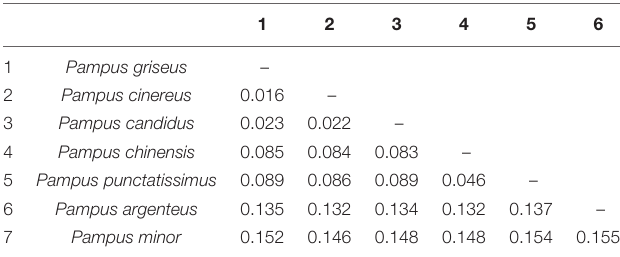
TABLE 2 | Genetic distance based on K2P model (Kimura, 1980) among the seven species of Pampus in the Indo-Western Pacific Oceans based on the concatenated data (1,822 nt).